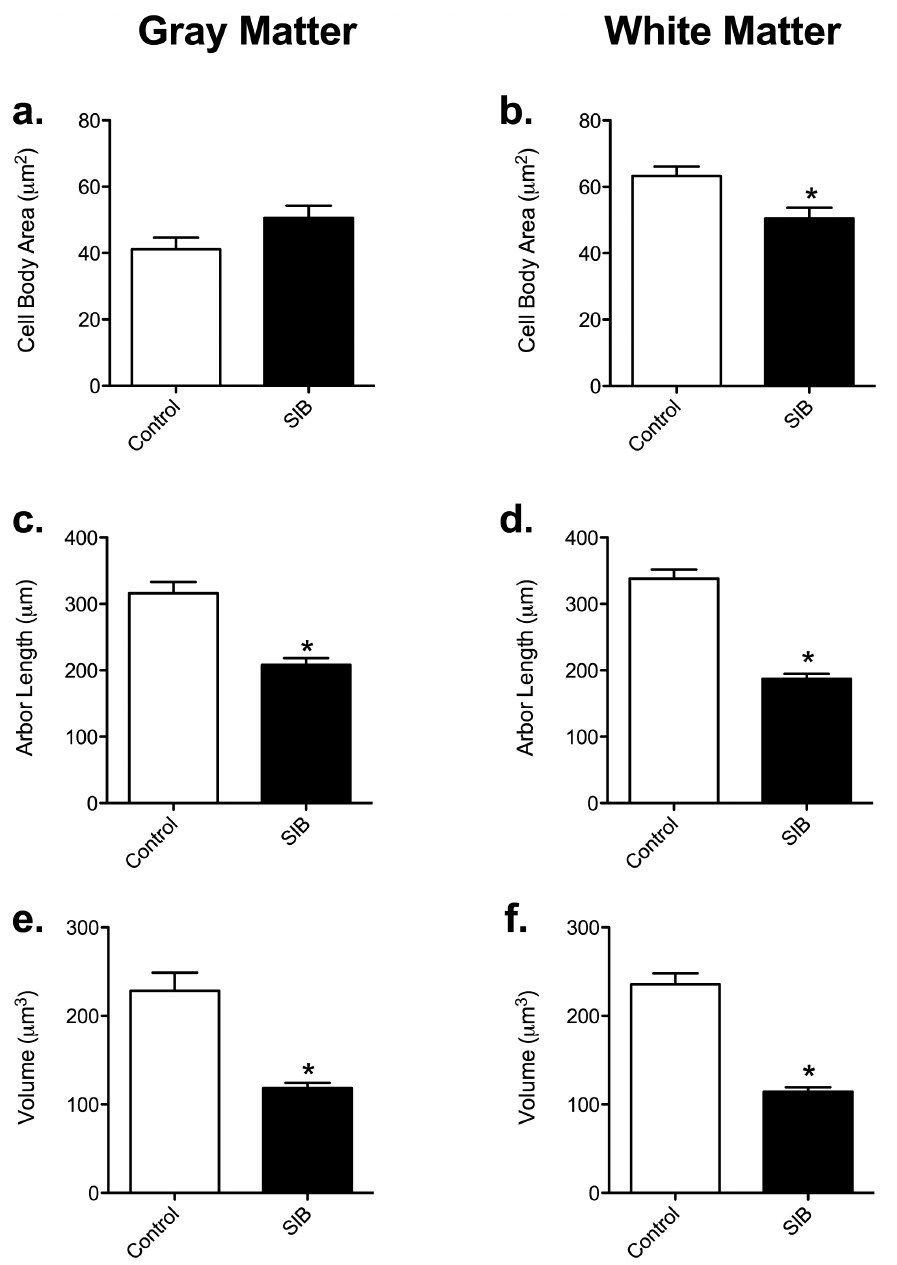
Figure 2. Astrocyte morphometrics in self-injurious behavior. The area of the astrocyte cell body was not significantly different in macaques with SIB in gray matter (a), but was decreased significantly in white matter astrocytes of SIB macaques (b). The cumulative length of the astrocyte processes was decreased in both gray (c) and white (d) matter, as was the overall volume of the processes (e & f, respectively). If a parameter is significantly different from the control, it is noted by an asterisk